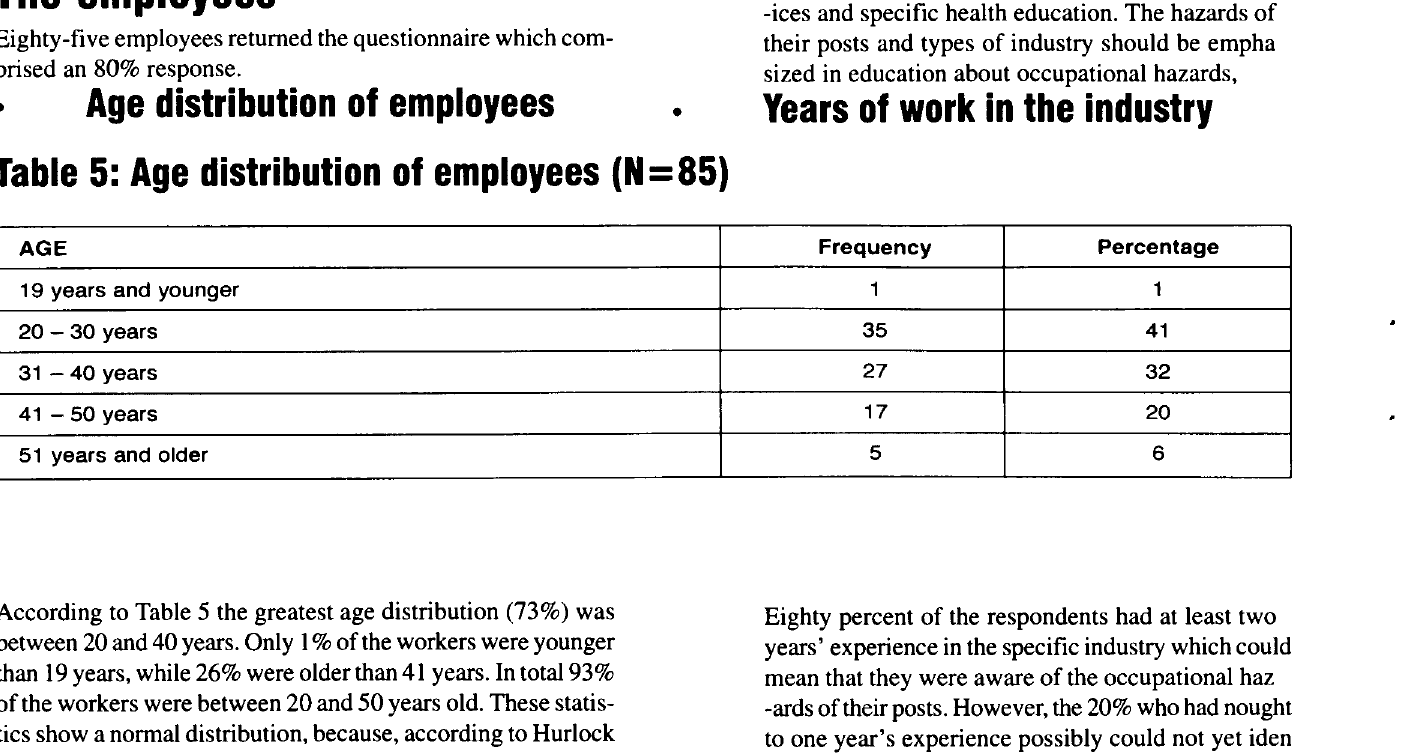
considered when planning occupational health serv -ices and specific health education. The hazards of their posts and types of industry should be empha sized in education about occupational